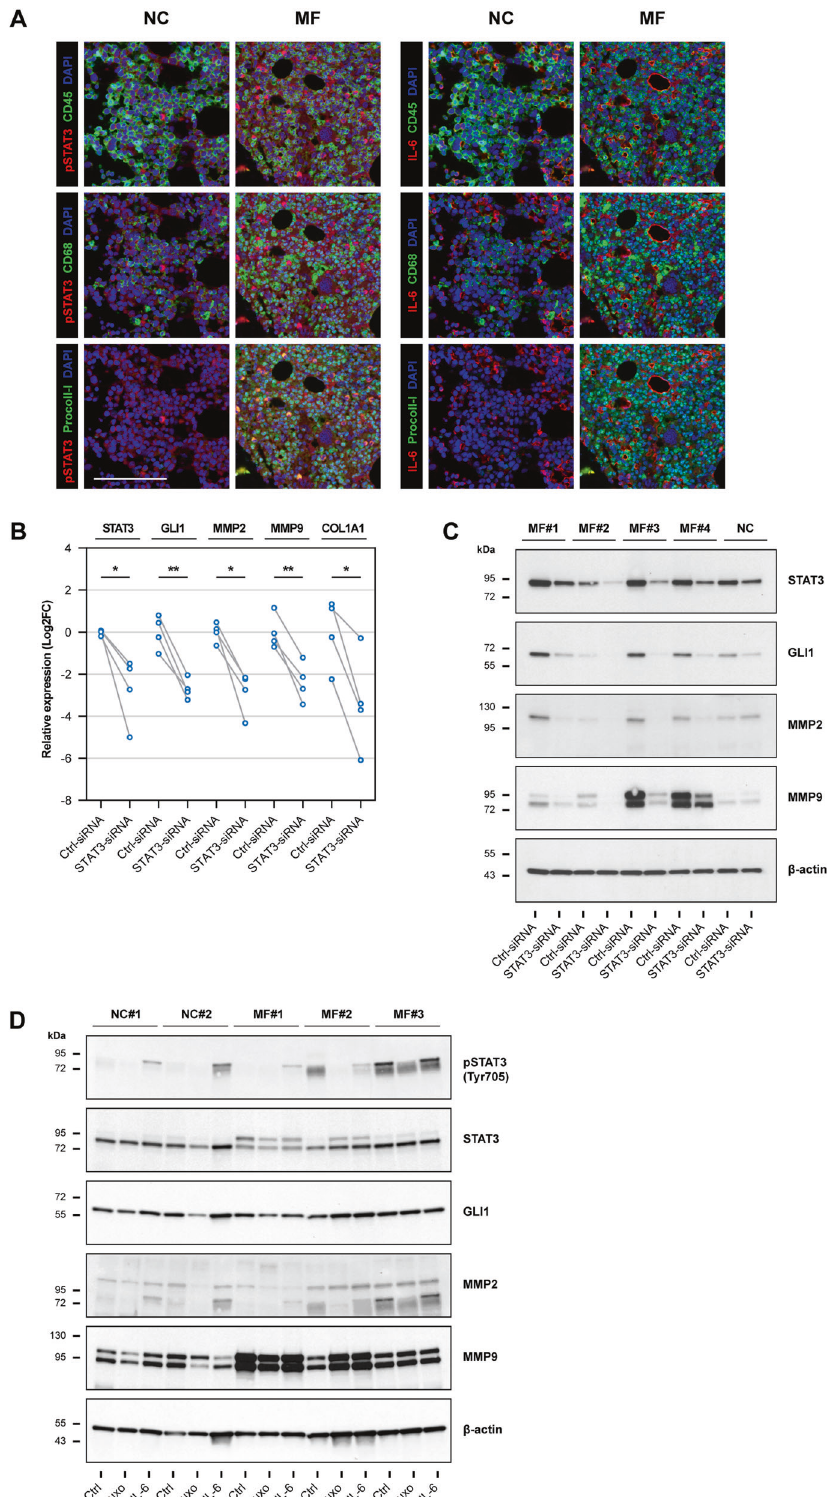
Multiplexed fl uorescence RNA in situ hybridization Cultured fi brocytes ’ mRNA levels were assessed by RNA in situ hybridization using the RNAscope Multiplex Fluorescent V2 assay and HybEZ II hybridization system (Advanced Cell Diagnostics, Newark, CA, USA). Cultured fi brocytes fi xed with 4% paraformaldehyde were dehydrated using ethanol gradient and, after rehydration and treatment with hydrogen peroxide and Protease III solutions,